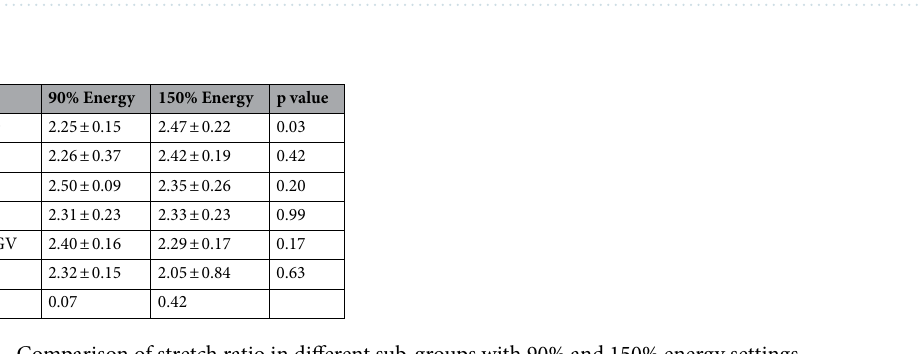
Table 4. Comparison of stretch ratio in different sub-groups with 90% and 150% energy